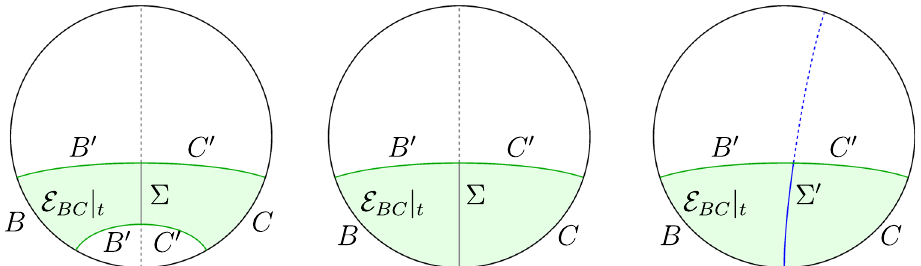
Fig. 5 Ingredients for the holographic computation of the entangle- ment of purification P and its generalization P (cid:3) . The disk represents a constant-time slice of a static geometry dual to some pure state. Upon restricting the field theory to the region A = BC , we are left in the grav- ity description with the corresponding spatial slice of the entanglement wedge of BC , shown as the shaded region. a In the generic case where B and C are not contiguous, the Ryu–Takayanagi surface (cid:2) BC has two disconnectedcomponents, indicatedingreen.Runningbetweenthemat the narrowest part of the shaded region we see the entanglement wedge cross section, (cid:15) , whose area encodes, according to (53), the entangle- ment of purification (52) for the bipartition BC of the given state. The corresponding minimal surface in the overall geometry would include